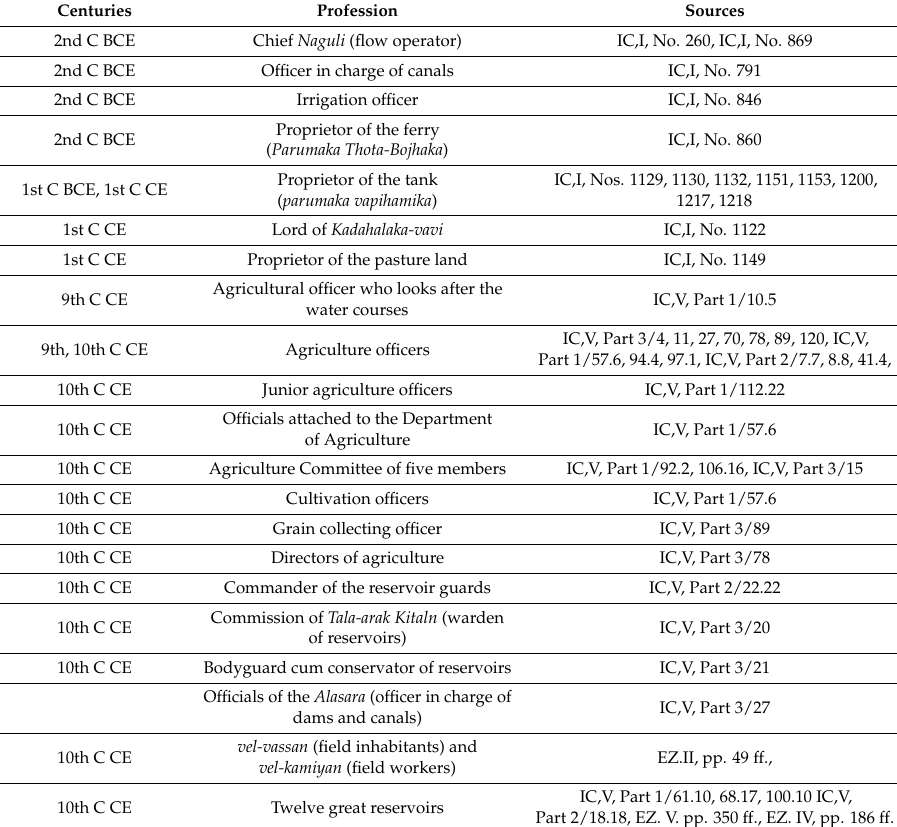
Table 4. Ownership of irrigation mentioned in ancient